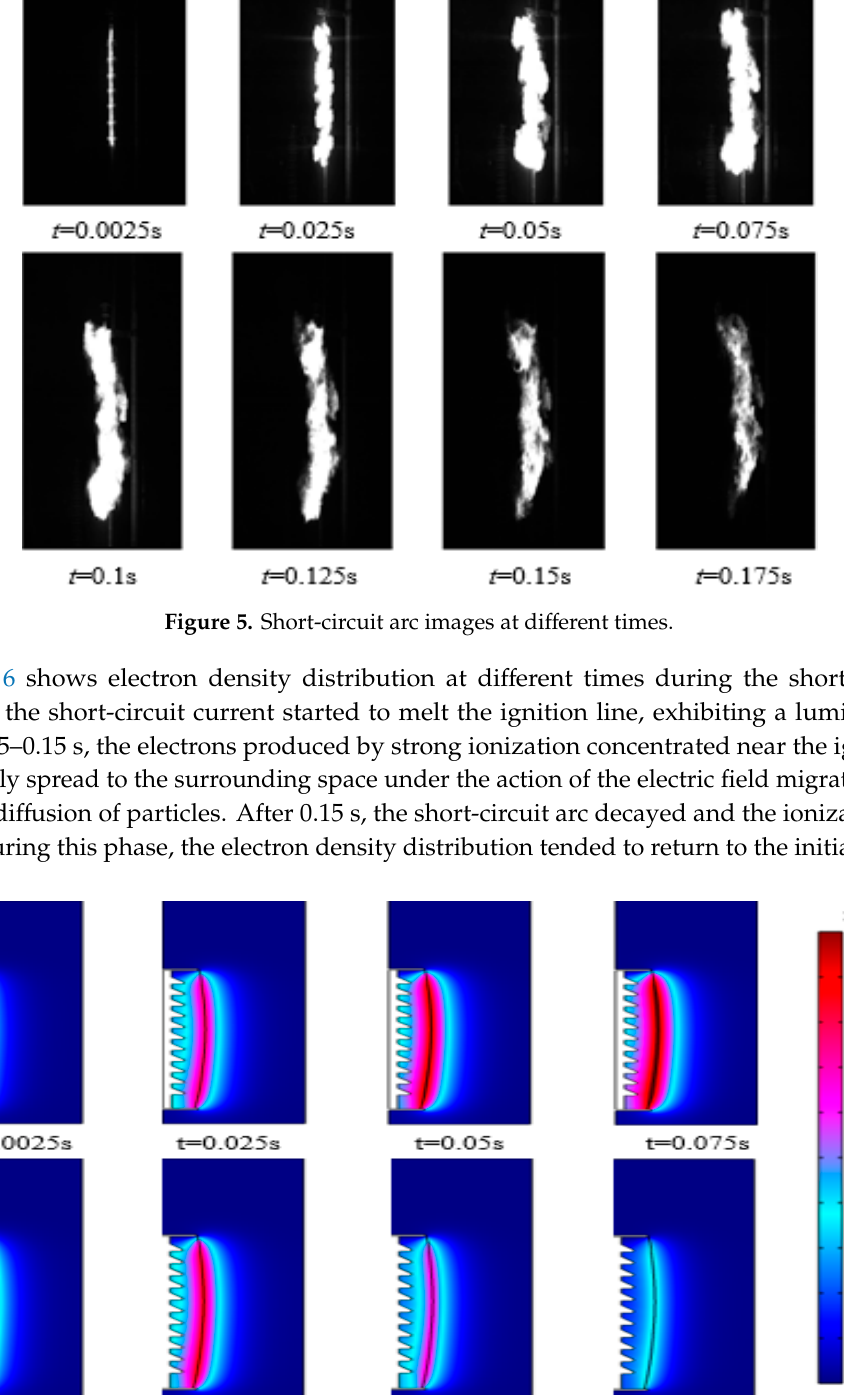
Figure 6. Electron density distribution at different times.